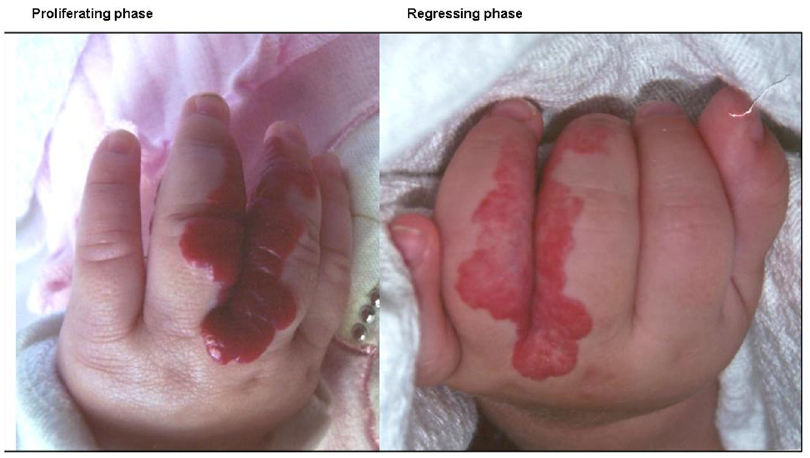
Figure 1. Representative image of IH at the proliferating phase (at month 6) and at regressing phase (at month 24).